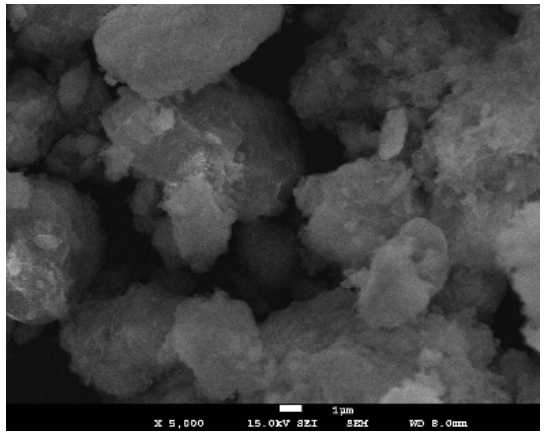
Figure 2. Crystal structure of ( a ) monoclinic Li 2 MnO 3 structure with space group C2/m and ( b ) rhombohedral LiMO 2 structure. M = Ni, Mn with space group R3m using VESTA software.